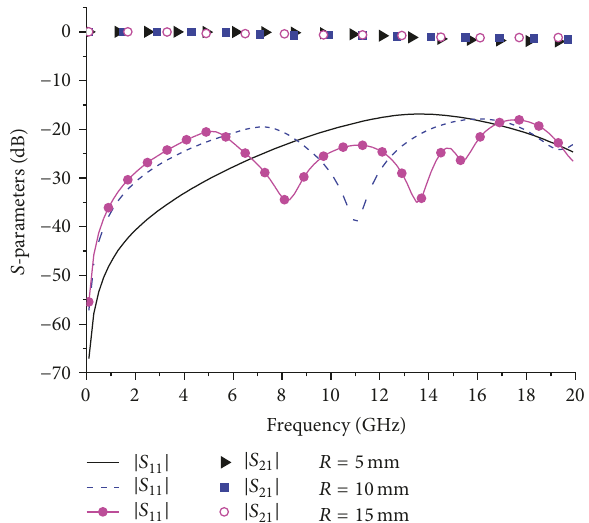
Figure 6: 𝑆 -parameters of circularly tapered conversion.